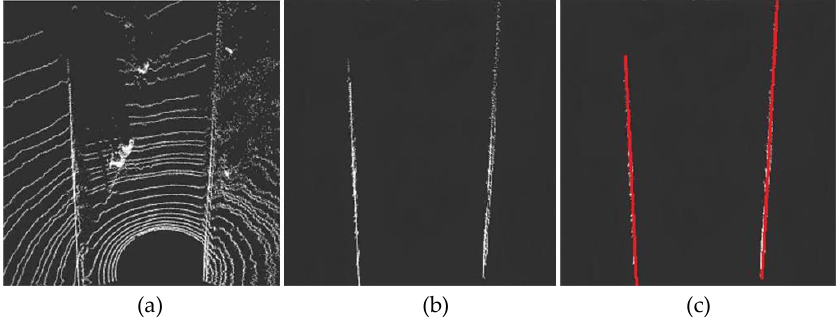
Figure 13. Curb detection under a complex road scene. ( a ) is the extracted foreground point clouds of road where there are obstacles. ( b ) is the boundary result extracted by the algorithm. ( c ) is the boundary fitting